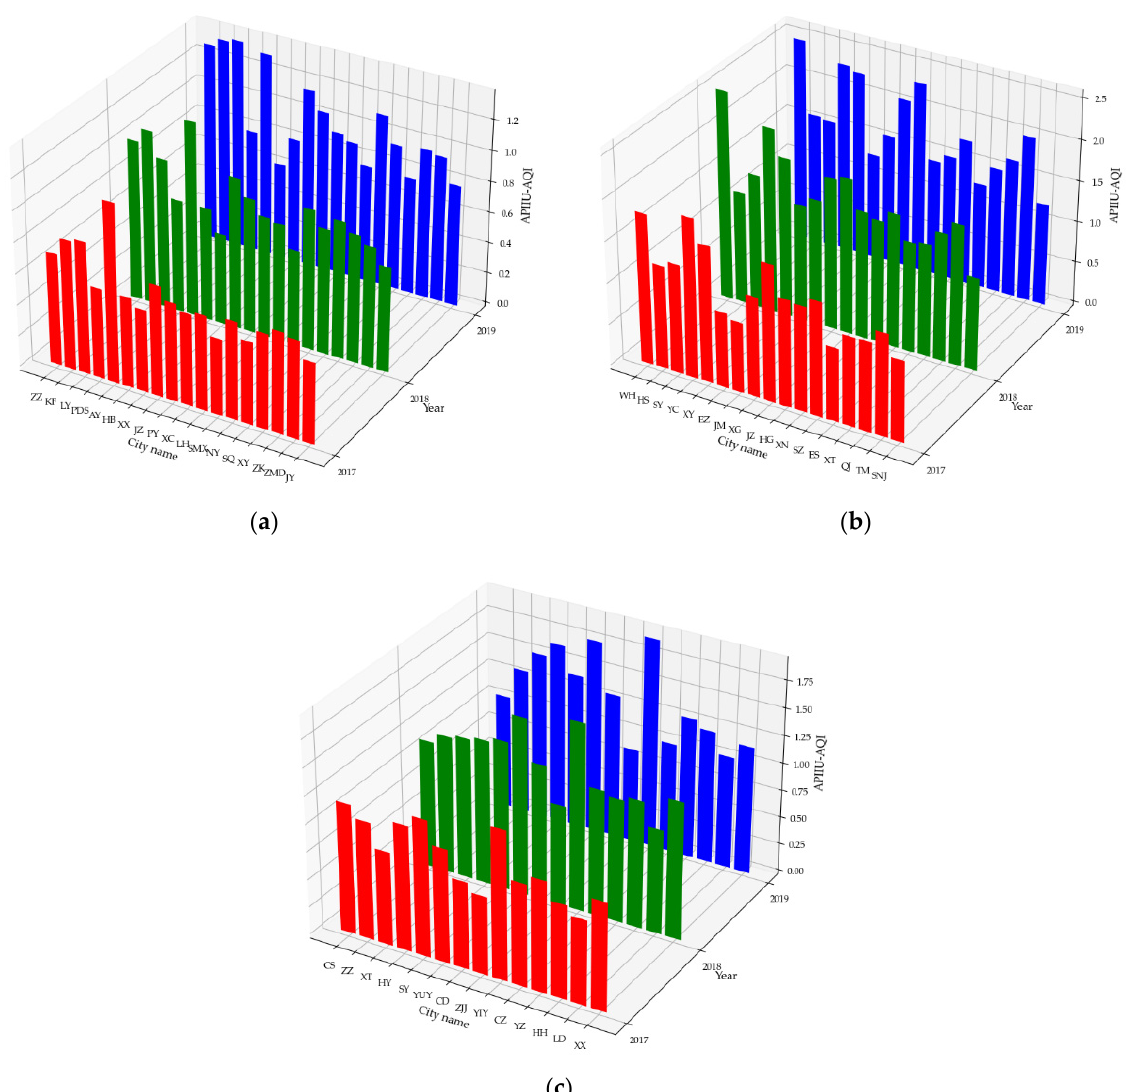
Figure 6. The changing trend of APIIU-AQI from 2017 to 2019: ( a ) Henan Province: Zhengzhou—